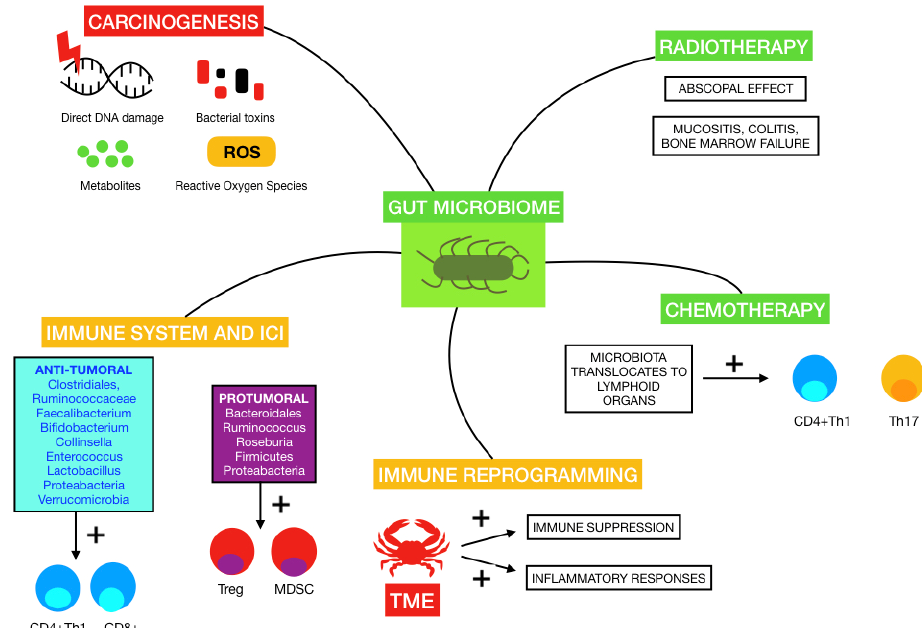
Figure 1. Influence of some of the mentioned gut microbiomes on carcinogenesis, immune system and response to immune-checkpoint inhibitors (ICI), immune reprogramming on tumor microenvi- ronment (TME), radiotherapy and chemotherapy.